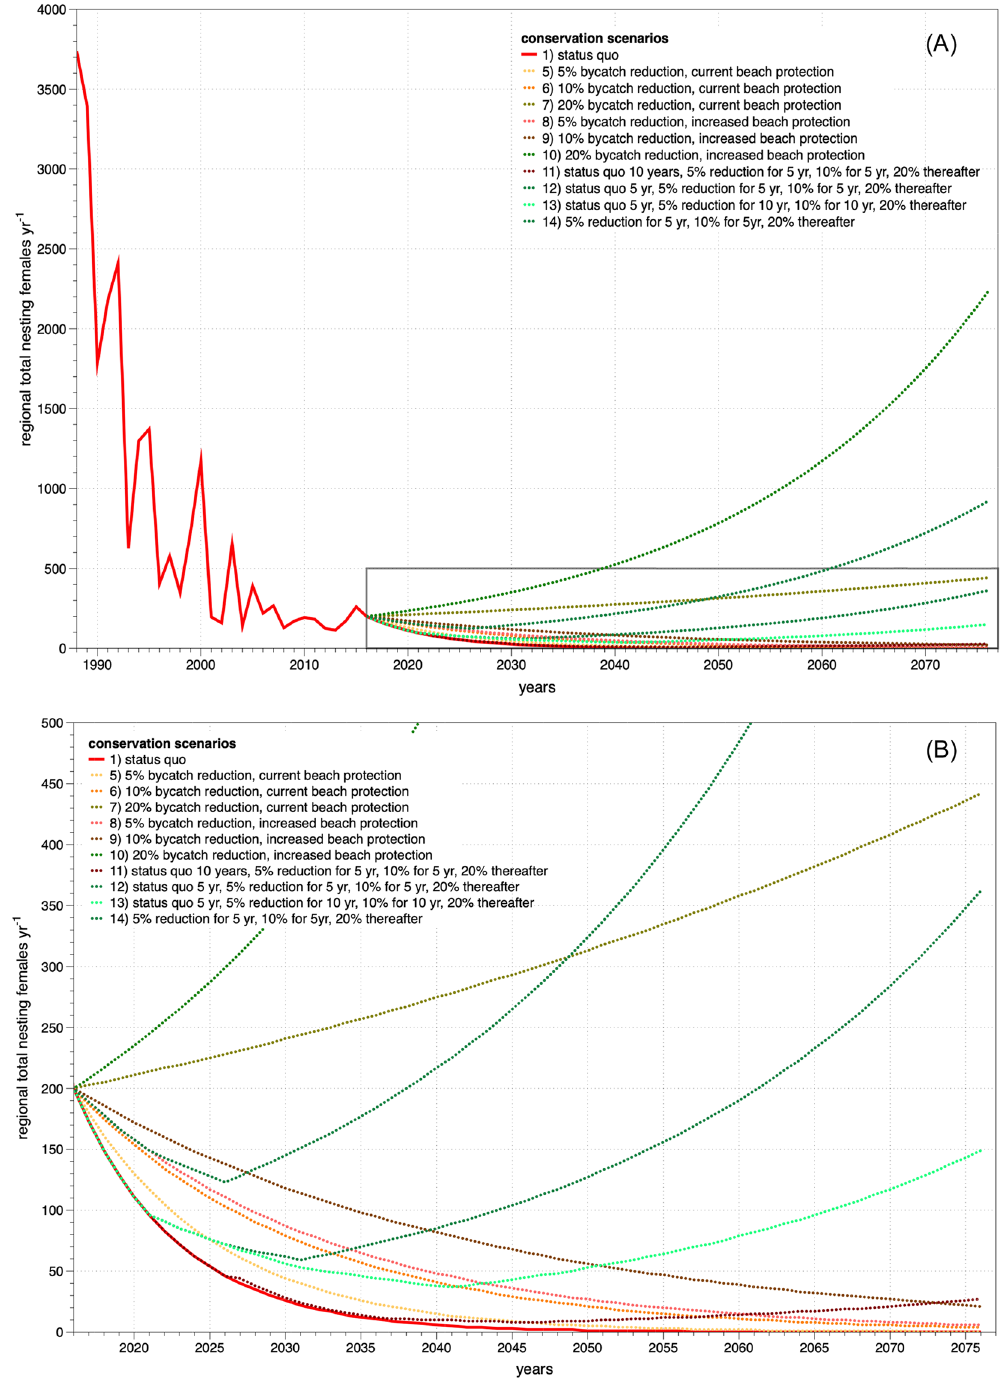
Figure 4. Modeled population projections under current and hypothetical conservation scenarios. Panel (A) shows data and projections from 1988 through 2076 (approximately three generations), while Panel (B) shows the area within the grey box (2016 through 2076; i.e., the next two generations) in more detail. Lines in red, orange, and yellow represent projections with negative population growth rates, while projections in green represent positive growth rate scenarios. The solid red line represents actual data through 2016, and future projections under status quo